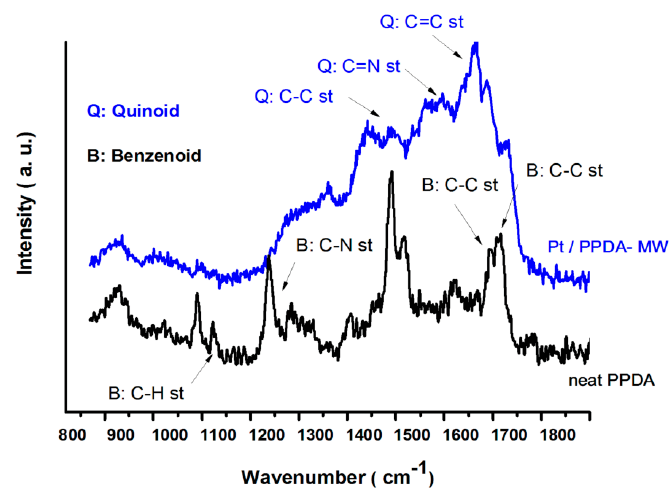
Figure 3. Raman spectra of neat PPDA and Pt/XC72-PPDA-MW.